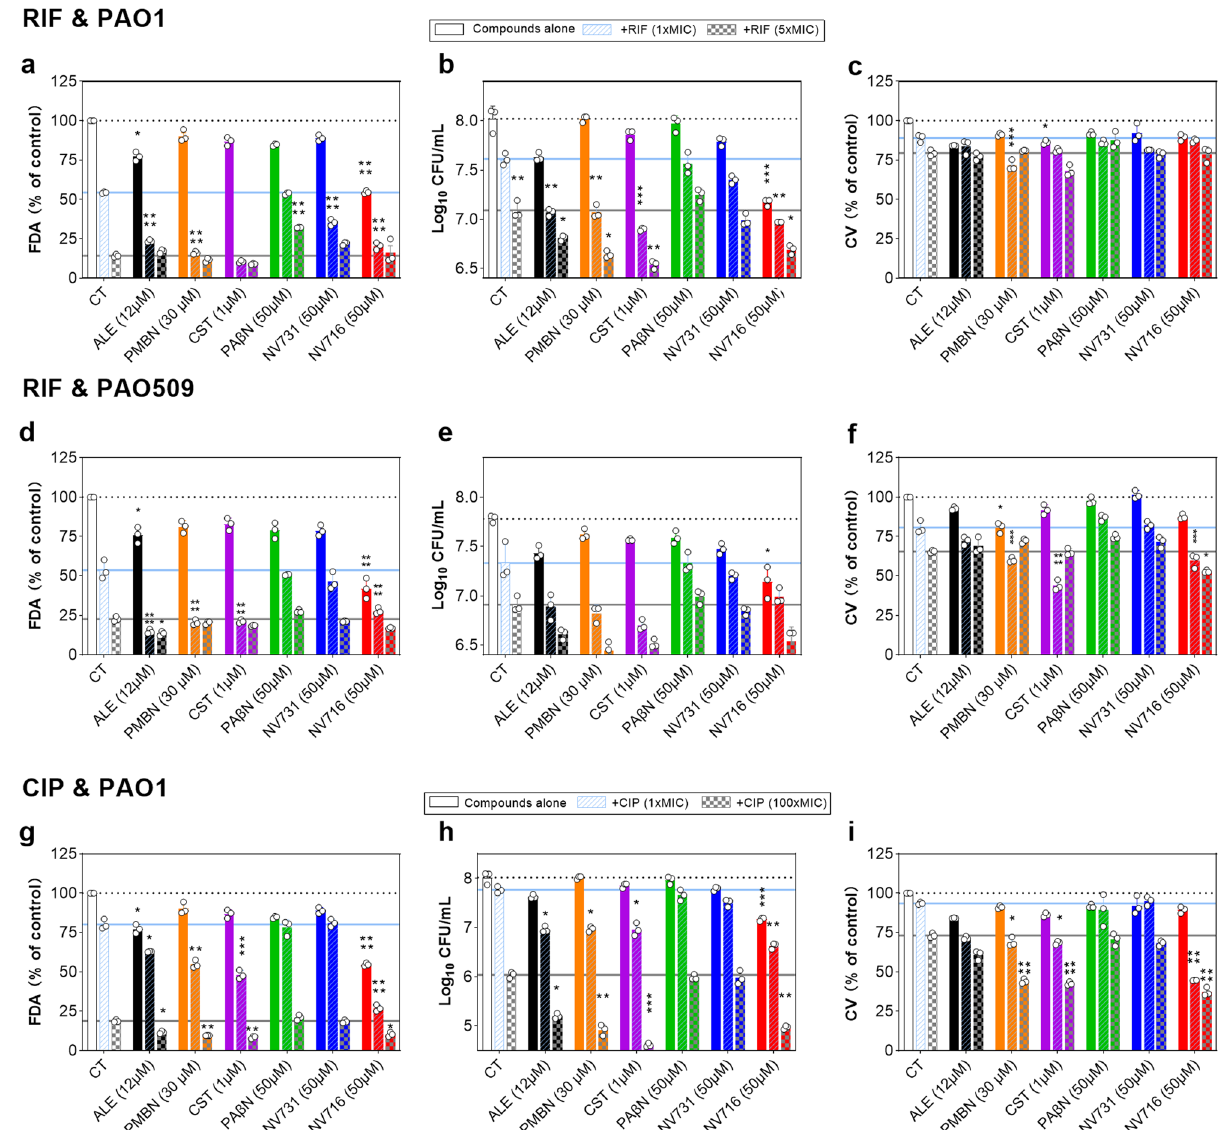
Fig. 8 Effect of potentiators on the activity of antibiotics against bio fi lms. Rifampicin against bio fi lms of PAO1 ( a – c ) and PAO509 ( d – f ); cipro fl oxacin against bio fi lms of PAO1 ( g – i ). Pre-formed bio fi lms were exposed during 24 h to rifampicin alone at 1 × MIC or 5 × MIC or to cipro fl oxacin alone at 1 × MIC or 100 × MIC, the potentiators alone (alexidine [ALE], polymyxin B nonapeptide [PMBN], colistin [CST]) at fi xed concentrations, or their combination (hatched bars: + RIF or CIP 1 × MIC; checkerboard bars: + RIF 5 × MIC or CIP 100 × MIC). The graphs show the metabolic activity ( a , d , g ; fl uorescein diacetate assay [FDA]), CFUs ( b , e , h ) and biomass ( c , f , i ; crystal violet [CV] staining), respectively. All data are mean ± SEM (triplicates from three independent experiments). In each graph, the black horizontal dotted line is the value for the control (non treated bio fi lm), the blue line, the value for the bio fi lm exposed to the antibiotic alone at 1 × MIC, and the gray line, for the bio fi lm exposed to RIF at 5 × MIC or CIP at 100 × MIC, respectively. Statistical analysis: comparison of potentiators alone to control bio fi lm or to potentiator combined with rifampicin to rifampicin alone (at the same concentration) by one-way ANOVA with Dunnett ’ s post-hoc test: * p < 0.05; ** p < 0.01; *** p < 0.001; **** p <